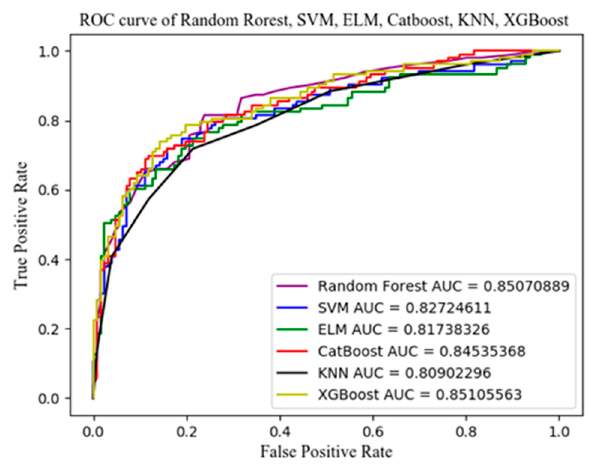
Figure 3. Receiver operating characteristic (ROC) curve of models.